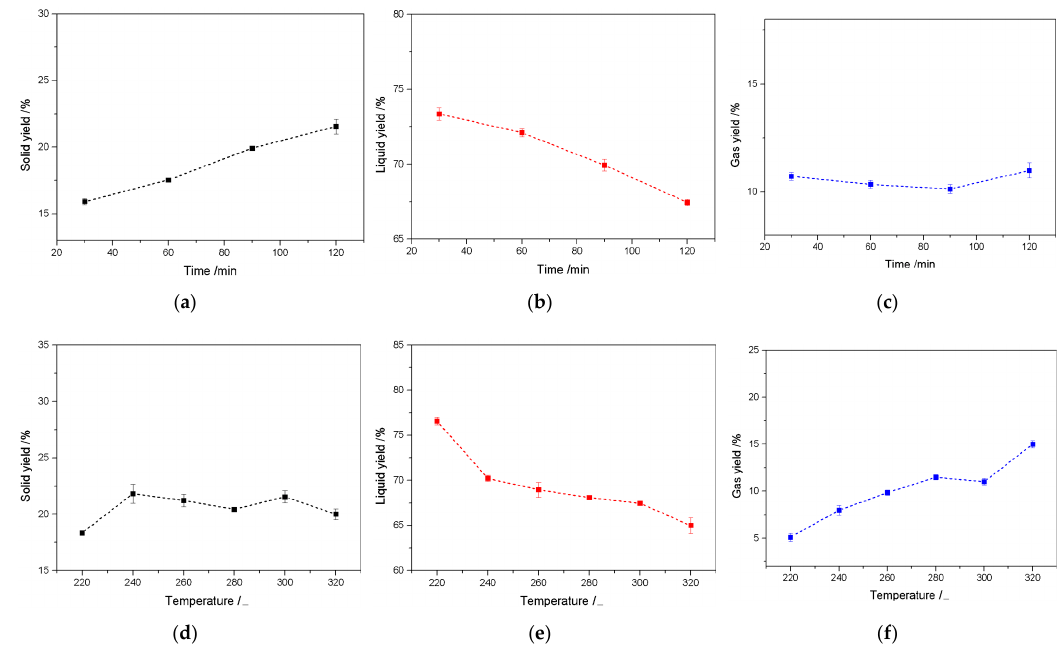
Figure 1. Effect of residence time (300 °C) and reaction temperature (120 min) on the yield of solid, liquid, and gas. ( a ) Solid yield; ( b ) liquid yield; ( c ) gas yield; ( d ) solid yield; ( e ) liquid yield; ( f ) gas yield.